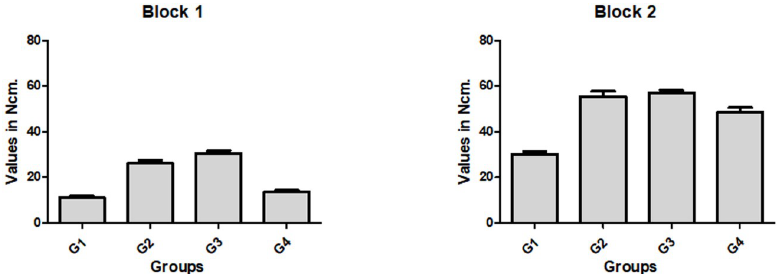
Fig 4. Bar graphs of the mean and standard deviation of insertion torque values measured for each group in both synthetic bone blocks used (blocks 1 and 2).